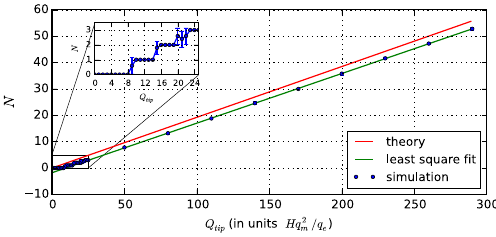
Figure 5. Plot for N vs Q tip . The inset shows zoom of the plot for range Q tip = 0